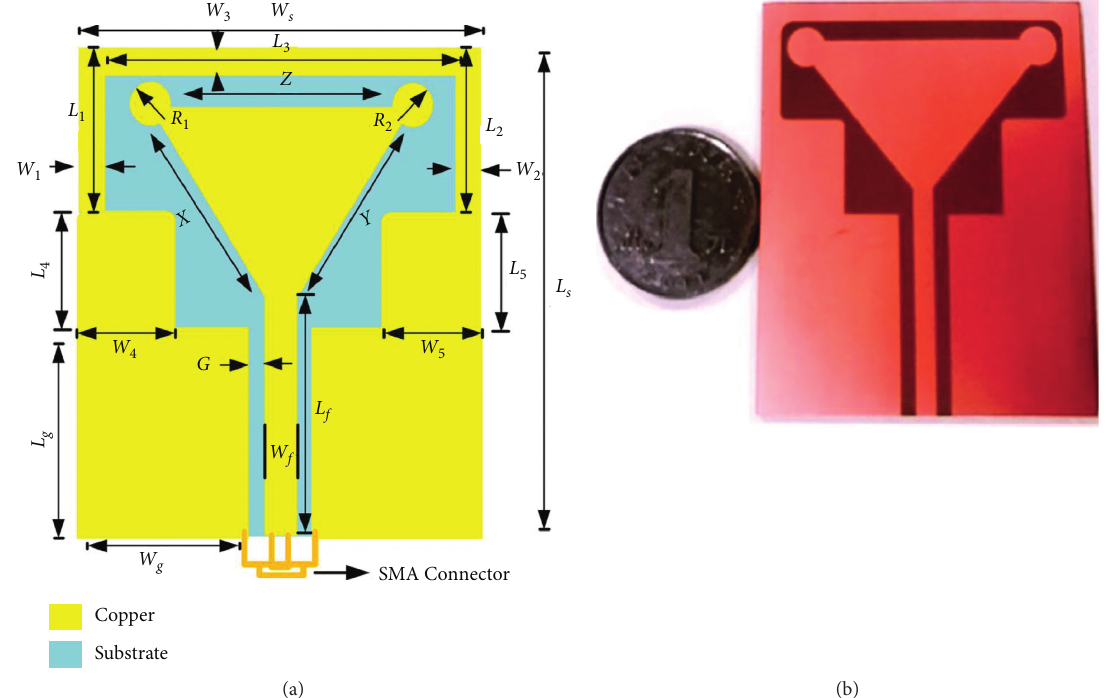
Figure 1: The geometrical structure of proposed antenna. (a) The designed antenna model with loaded circular disc-shaped stubs and modified ground plane. (b) The fabricated prototype of antenna with one Chinese yuan